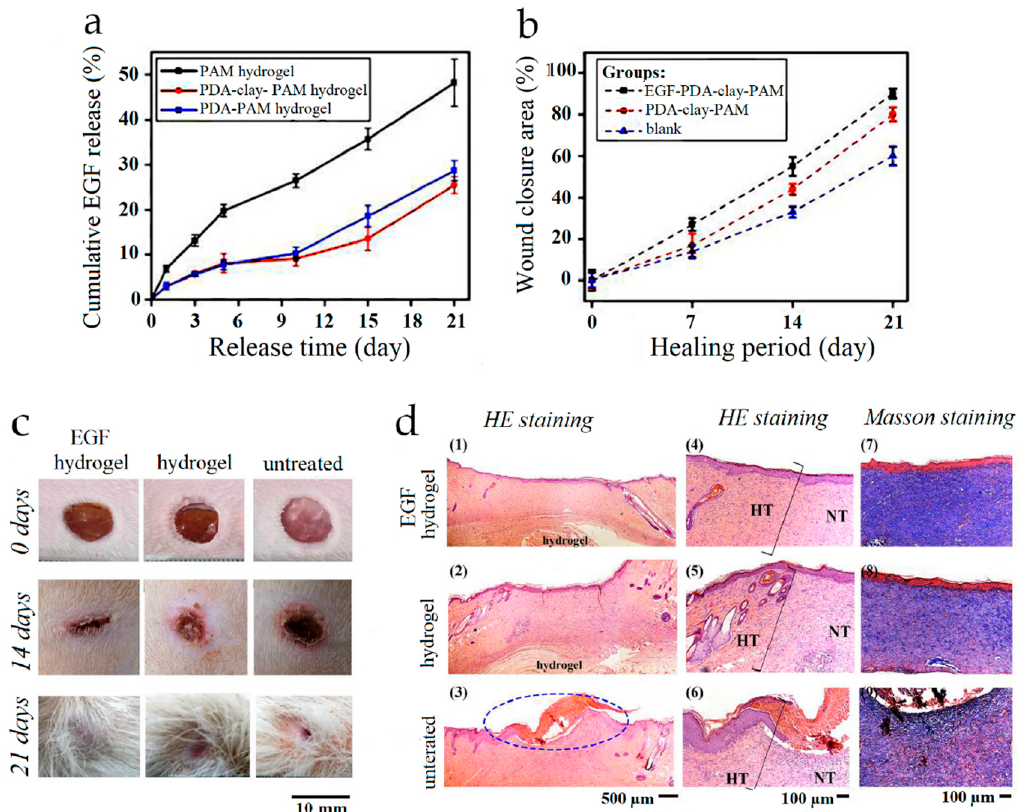
Figure 11. Polydopamine (PDA)-clay-polyacrylamide (PAM) hydrogel as a wound dressing in a full-thickness skin defect. ( a ) Cumulative EGF released from PDA-clay-PAM, PDA-PAM, and clay-PAM hydrogels in PBS. ( b ) Wound closure of untreated defects and defects treated with EGF-loaded PDA-clay-PAM, EGF-free PDA-clay-PAM, and PDA-PAM. ( c ) Digital photos of the wound after 0, 14, and 21 days of healing. ( d ) Photomicrographs showing histological staining of wound sites on day 21. (1 − 3) Overview of the defects treated by epidermal growth factor (EGF)-loaded PDA-clay-PAM hydrogel and PDA-clay-PAM hydrogel and untreated defect. (4 − 6) The interface between the newly regenerated tissue (NT) and host skin tissue (HT). (7 − 9) Masson staining of the collagen deposited in the defects. Reproduced with permission from [94]. Copyright American Chemical Society, 2017.